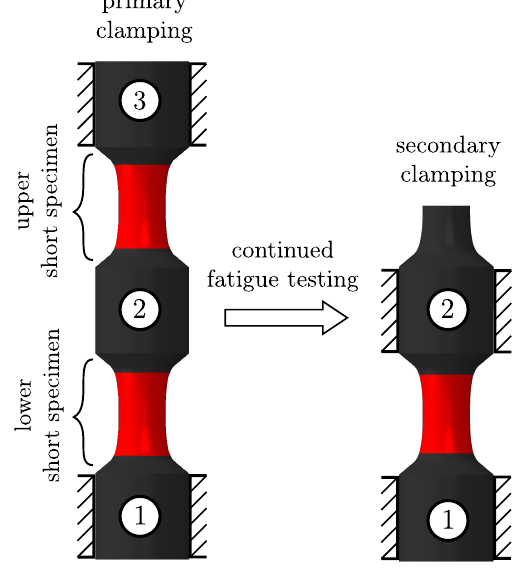
Figure 6. First and second testing of specimen type